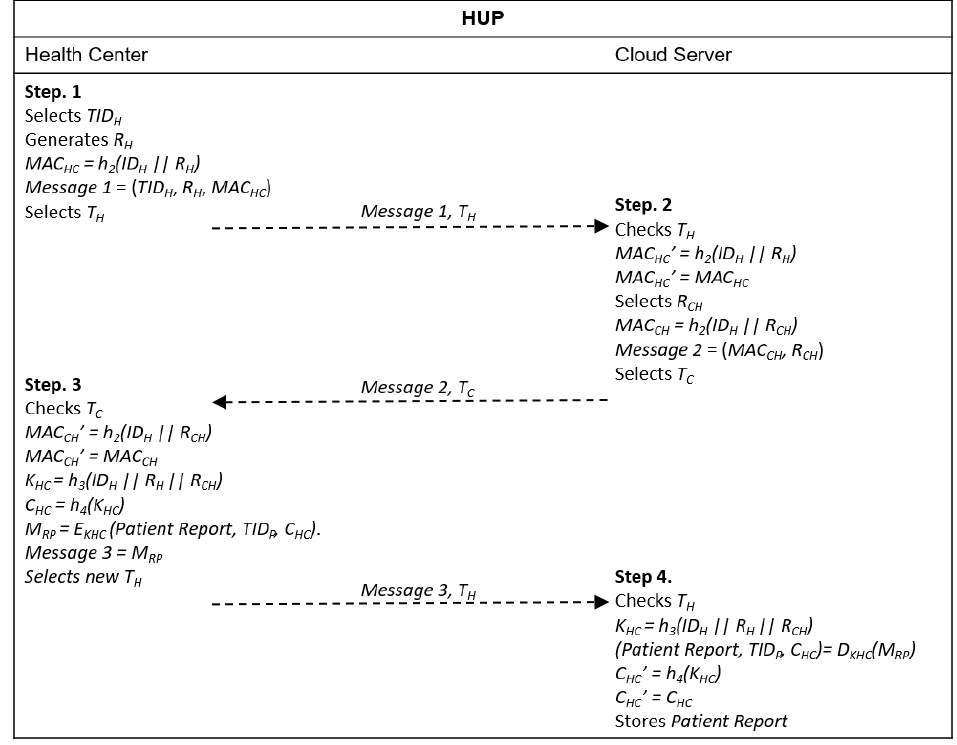
Figure 2. Message exchange in health center upload